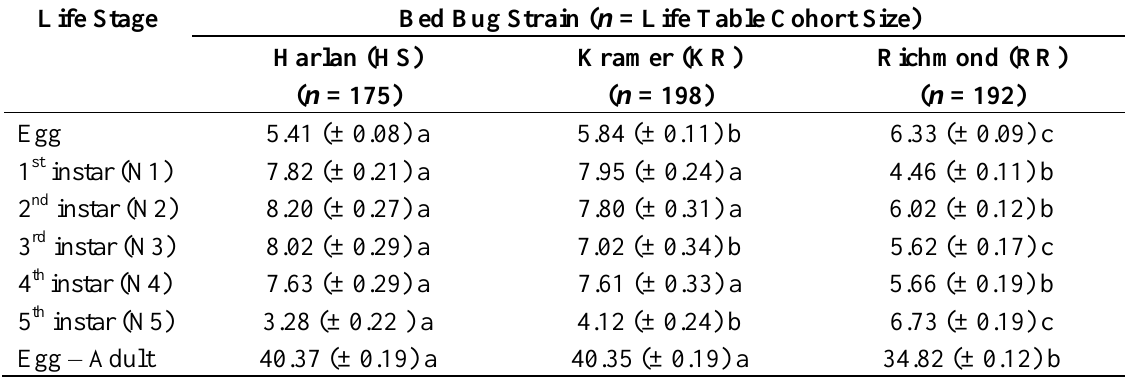
Table 3. Mean (± 95% CI) duration of each life stage (days) for two pyrethroid-resistant (KR and RR) and one susceptible strain of the common bed bug, Cimex lectularius